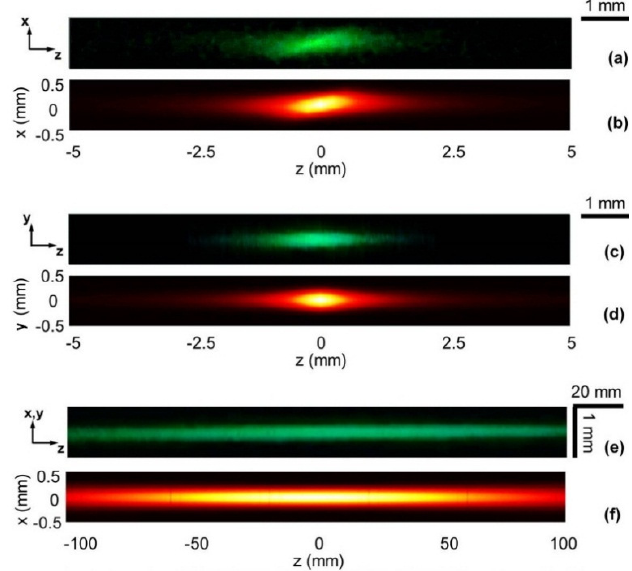
Figure 5. Fluorescence images ( a – d ) with and ( e , f ) without SSTF. The focal length of focusing lens is 500 mm; ( a , c , e ) are the images of fluorescence recorded in the experiment; and ( b , d , f ) are the corresponding numerical simulation results of fluorescence signals. Reproduced with permission from [24], Copyright The Optical Society, 2014.